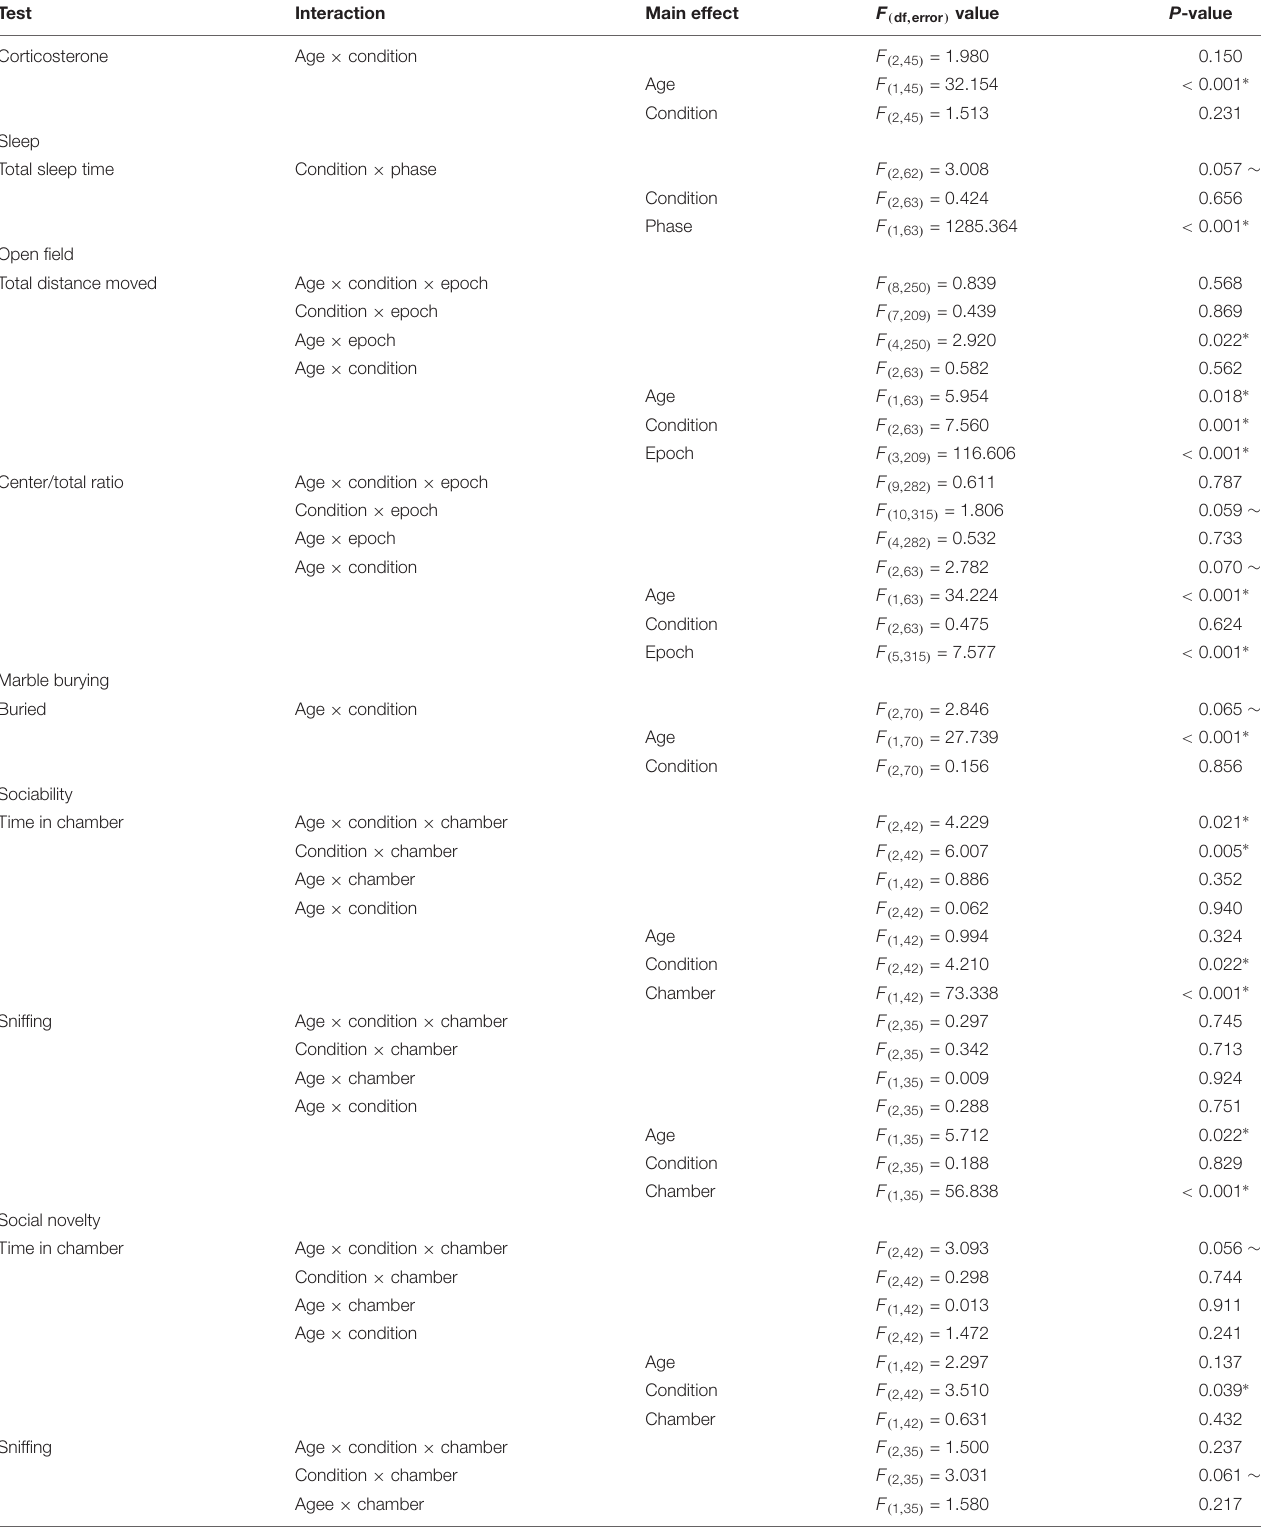
TABLE 2 | Repeated measures ANOVA